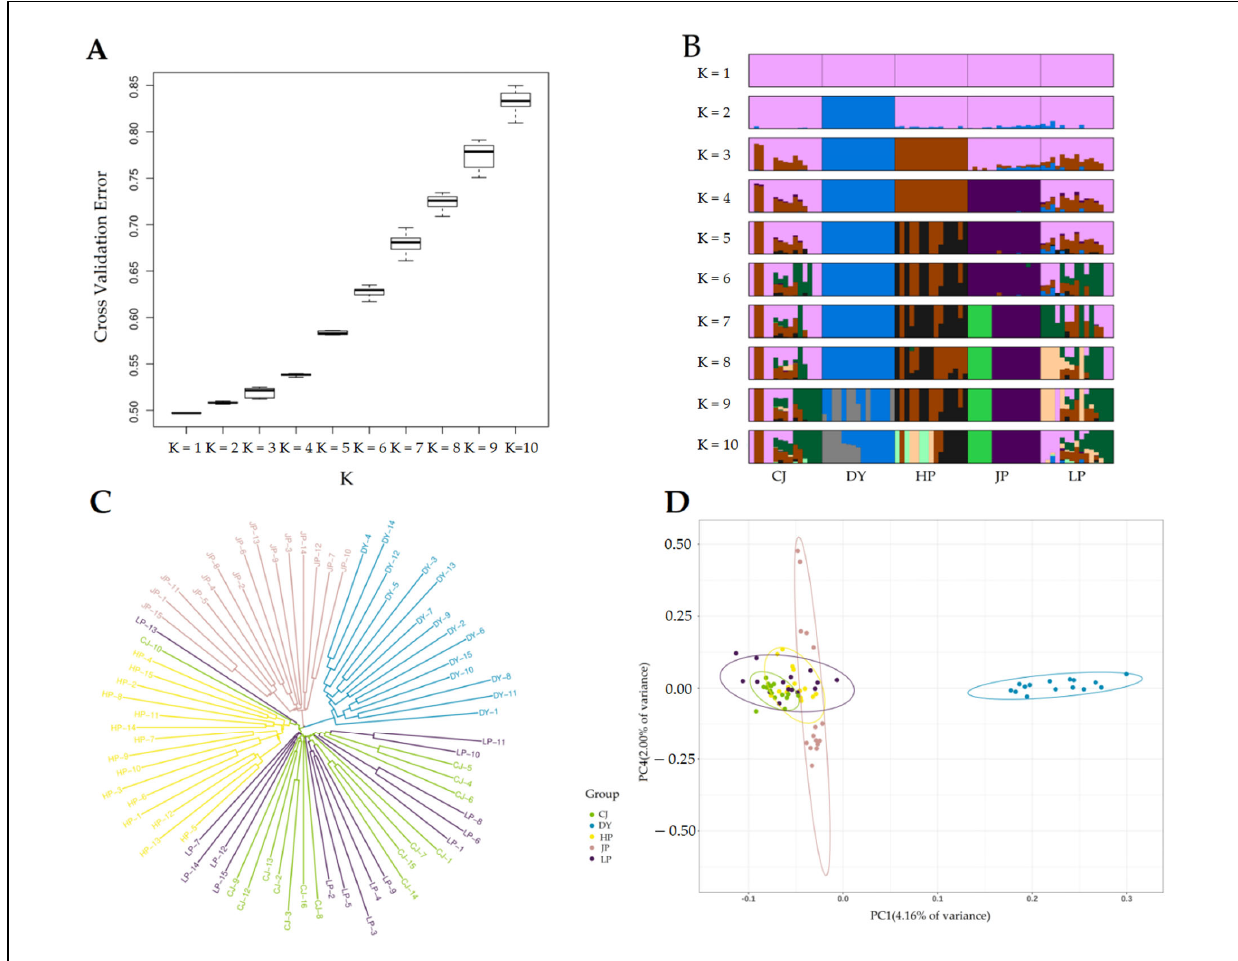
Figure 3. Genetic structure of five populations of golden ‐ backed carp in Guizhou, China. CJ, DY, HP, JP and LP denote the Congjiang, Duyun, Huangping, Jinping and Liping populations, respectively. ( A ) A cross ‐ validation error box plot. (The abscissa takes different K values, which indicate the number of hypothetical populations, while the ordinate represents the cross ‐ validation error value. The cross ‐ validation error of K values ranges from 1 to 10; generally, the lowest CV value is the optimal K value, but the results of other analyses need to be considered). ( B ) Based on the 5 populations of golden ‐ backed carp, pong clustering was performed for multiple replicated results of each K value from 1 to 10 (each individual is represented by a single vertical line divided into K colours, where K is the number of clusters assumed, and different colours represent different populations. Black lines separate individual populations whose names are indicated below the diagram). ( C ) Neighbour ‐ joining tree of 75 individuals in the 5 populations based on 44,896 SNPs. ( D ) Principal component analysis (PCA) was performed based on the degree of SNP differentiation in individual genes (PC1 and PC2 with the largest SNP variance were selected as the horizontal and vertical axes for PCA).